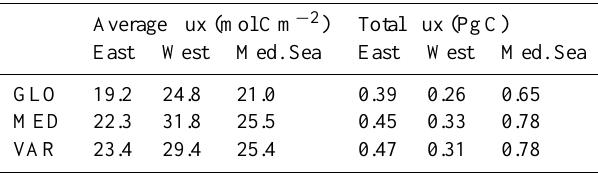
Table 2. Cumulative air–sea flux between 1800 and 2001 for the three simulations over the eastern and western basins and the entire Mediterranean Sea.